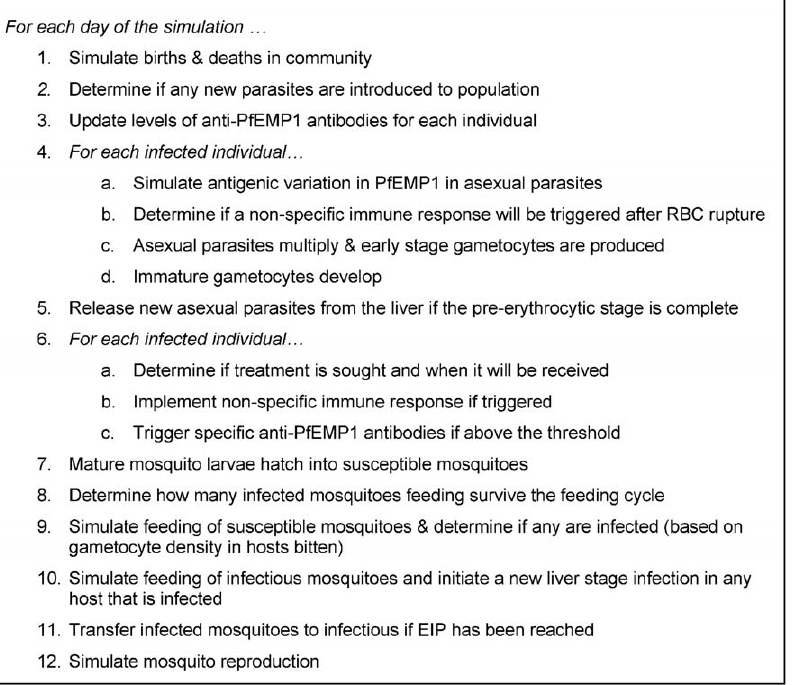
Figure 1. Description of processes, and order of application, for the malaria transmission model.